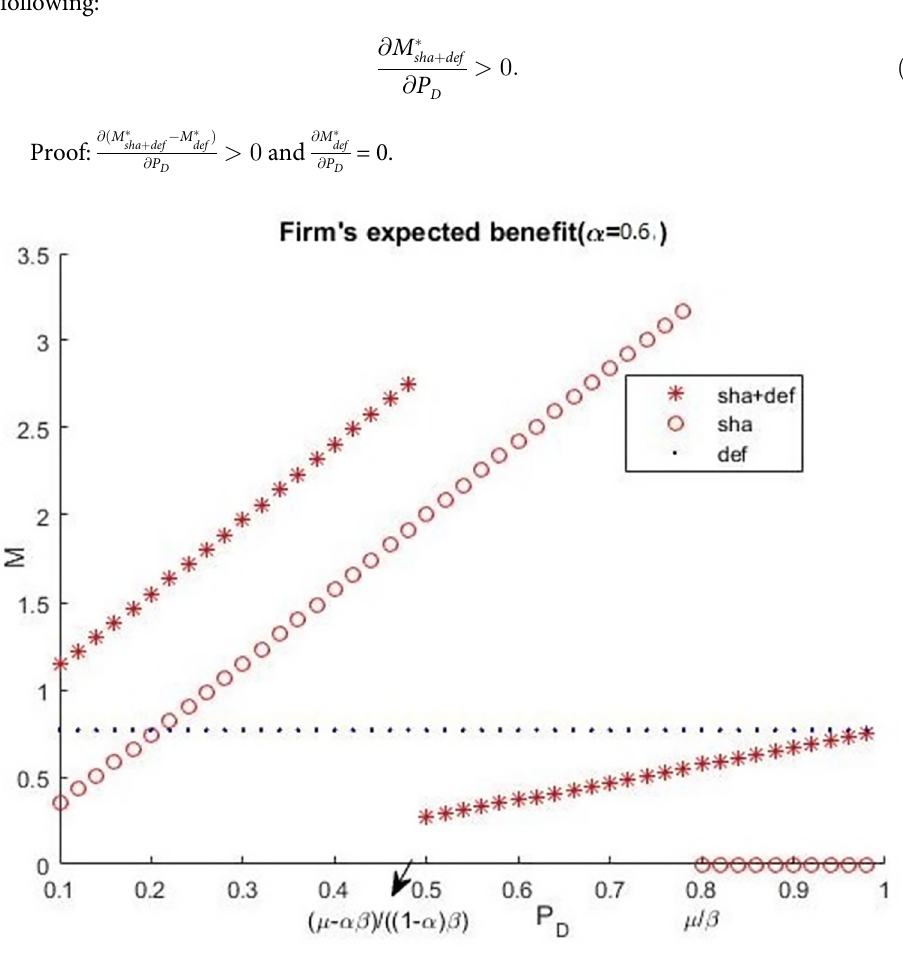
Fig 5. Firm’s expected benefits ( α =